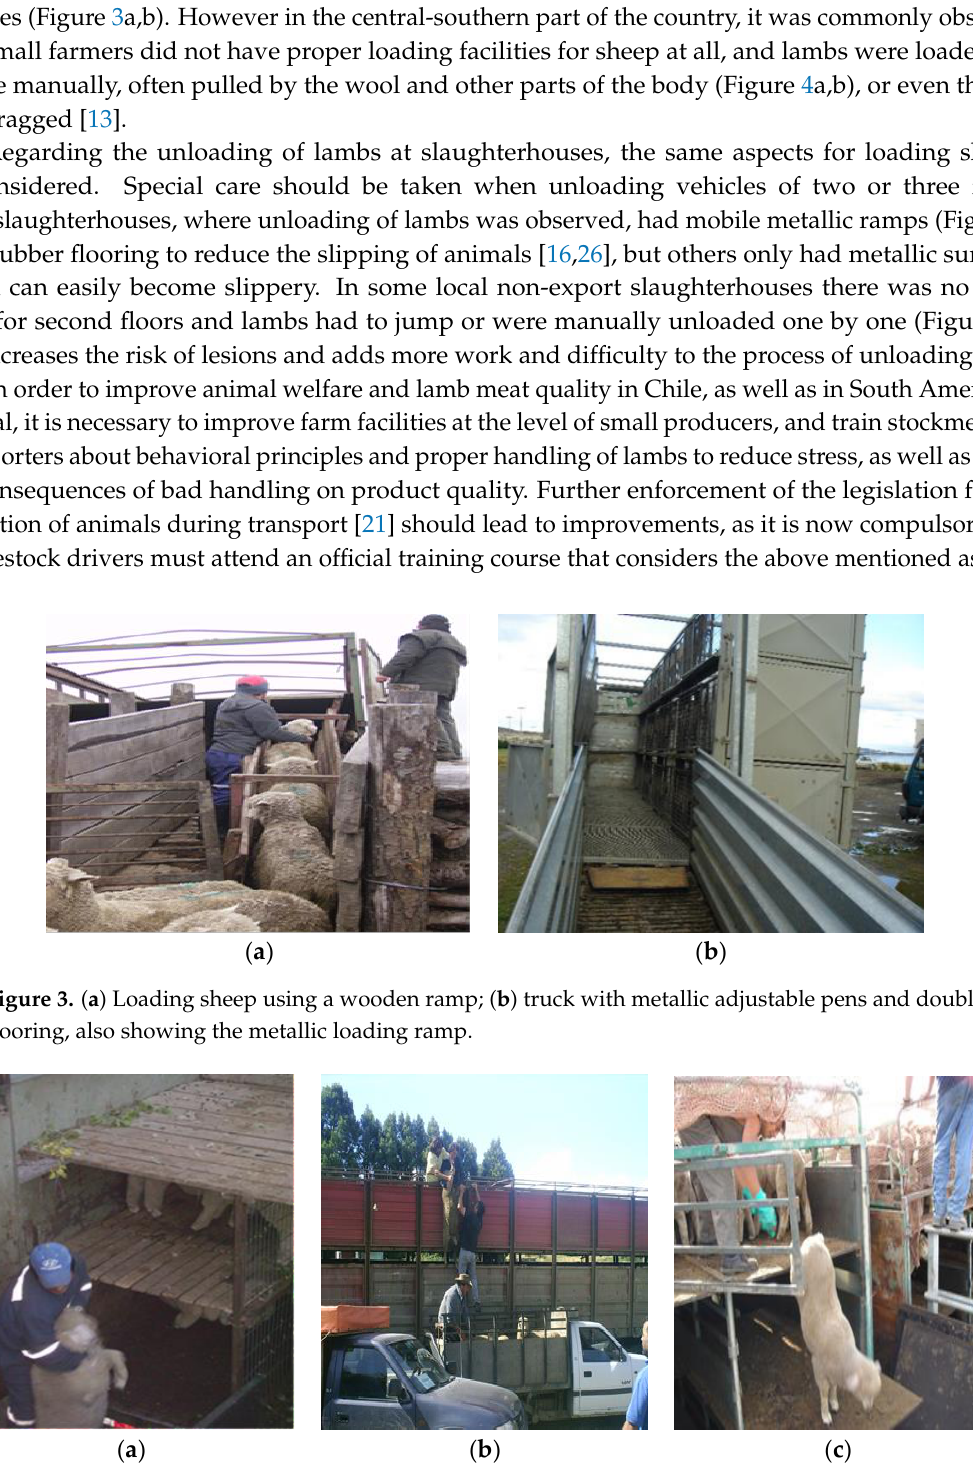
Figure 4. Inadequate practices for loading ( a , b ) and unloading lambs ( c ).